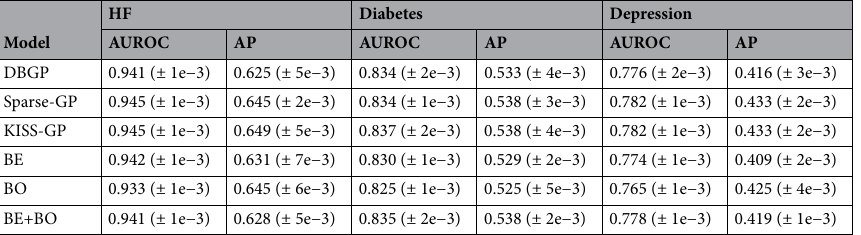
Table 1. Metrics for marginalized predictions on heart failure, diabetes, and depression. 95% confidence intervals are computed via a validation set bootstrapping with 50 bootstrap sets. AP average precision.